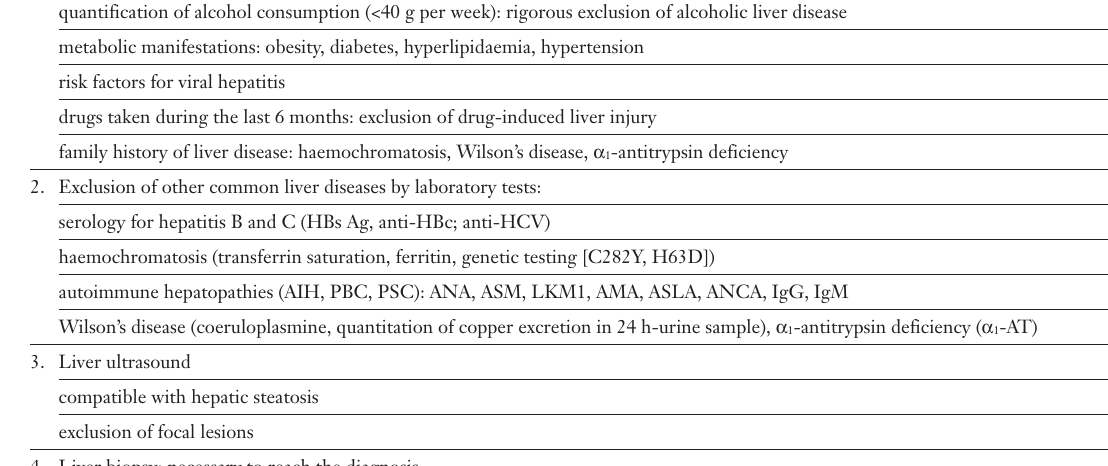
Diagnostic approach to a patient sus- pected to be suffer- ing from